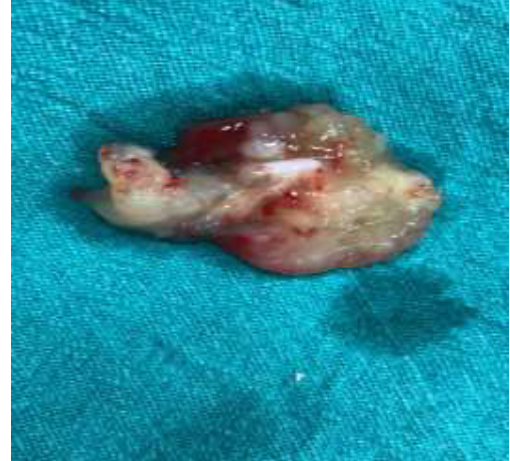
Figure 3. Papillary form of cardiac myxoma ventricular myxomas, respectively. The mean size of the resected tumors was 3.9 cm for benign tumors. All the left atrial myxomas (n=41) were pedunculated except for one, which was sessile. The tumors were yellow-brown or green globular-shaped masses with soft and gelatinous consistency (Figure 2) and often contain the areas of haemorrhage and necrosis. The papillary forms of myxoma were present in 10 patients (22%), all of whom had embolism (Figure 3).